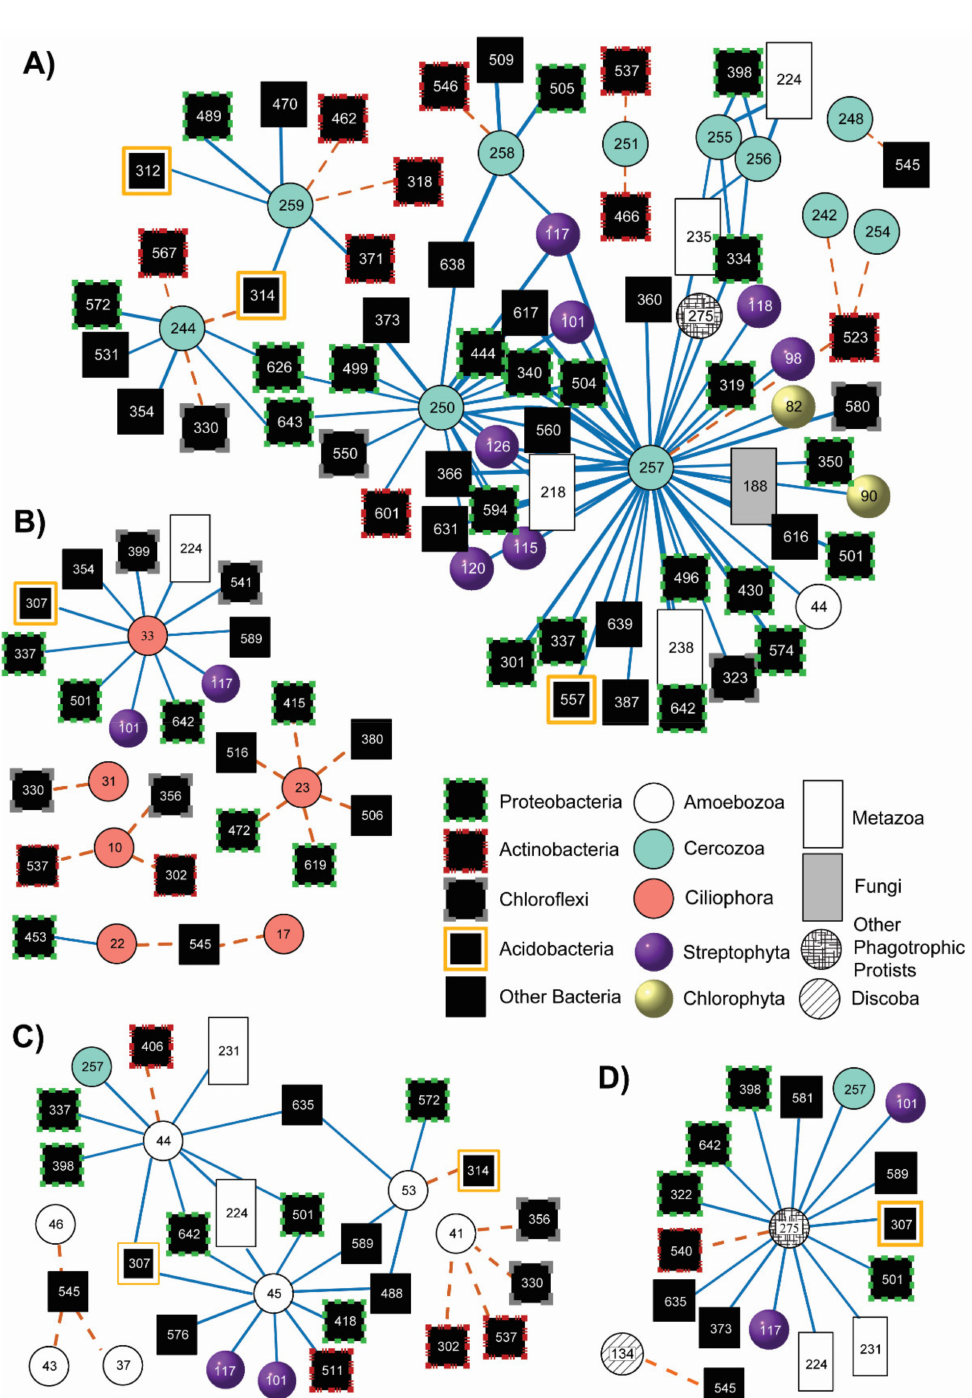
Figure 2. ( A – D )—Networks suggest a complex food web structure. Visualizations of pairwise co-occurrence associations for ( A ) Cercozoa, ( B ) Ciliophora, ( C ) Amoebozoa, and ( D ) Discoba and ‘other phagotrophic protists’. Visualization of the non-random positive (aggregate, blue solid lines) and negative (segregate, orange dashed lines) interactions resulting from pairwise co-occurrence analysis. Line length adjusted to avoid overlap of OTUs. ‘Other phagotrophic protists’ include those phagotrophic protists that do not fall under Ciliophora, Amoebozoa, Discoba or Cercozoa (e.g., Apusomonadida, Telonemia, and phagotrophic